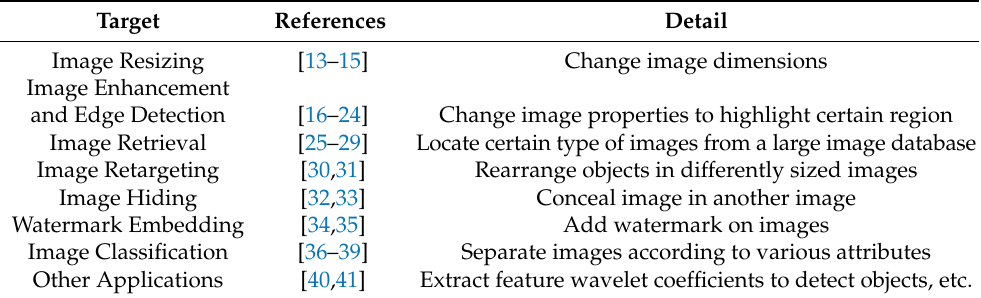
Table 1. Summary of compression domain processing on image